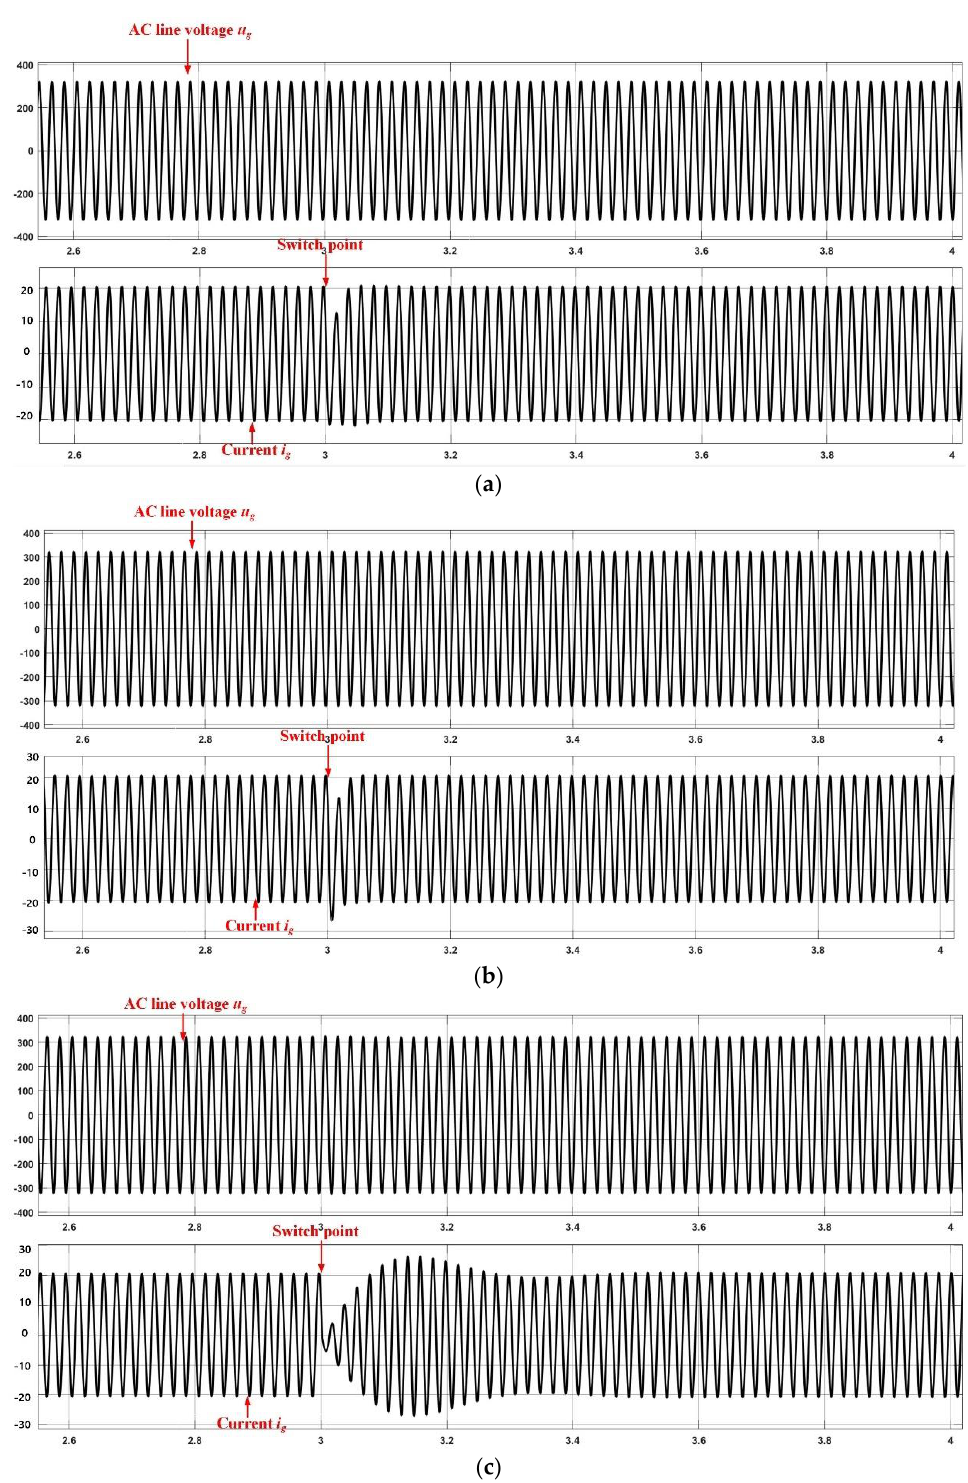
Figure 20. Dynamics of AC line voltage, synchronverter current, and disturbance with different grid strengths: ( a ) responses with SCR = 15.4; ( b ) responses with SCR = 2.5; ( c ) responses with SCR =